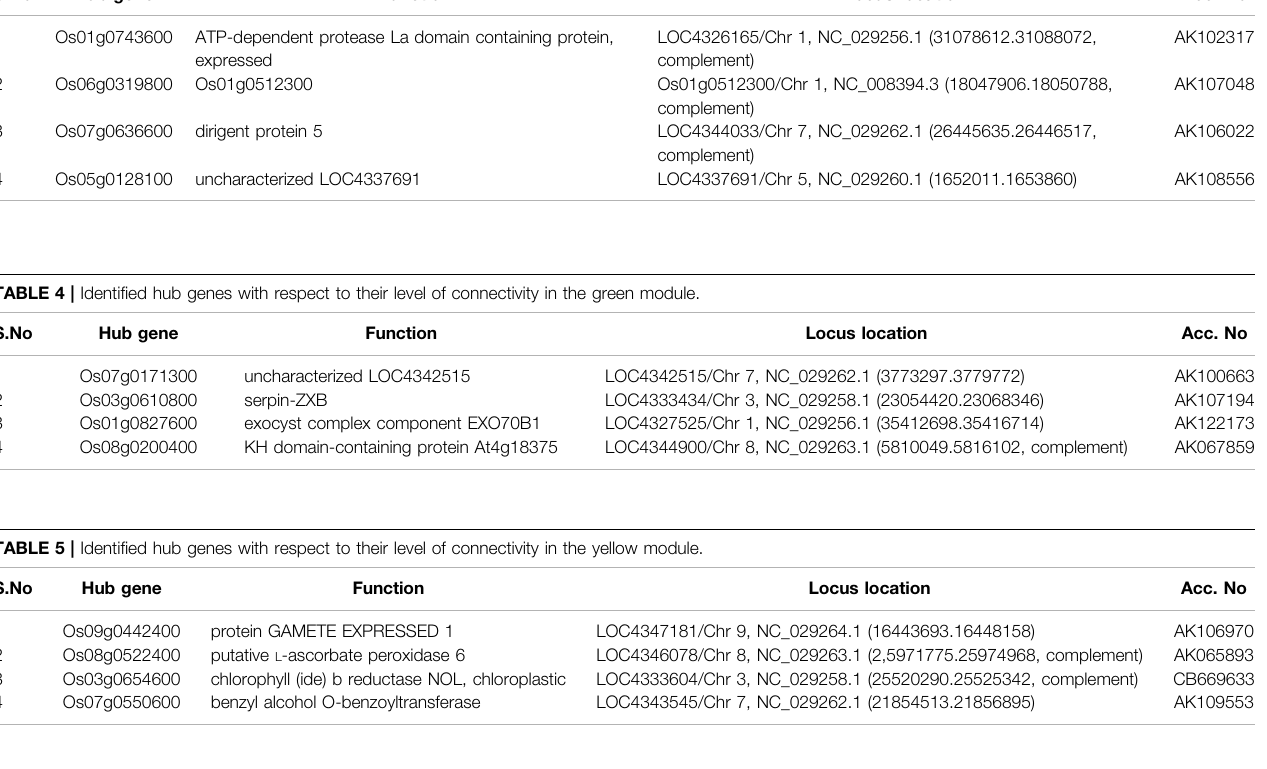
TABLE 6 | Identi fi ed hub genes with respect to their level of connectivity in the red module. S.No